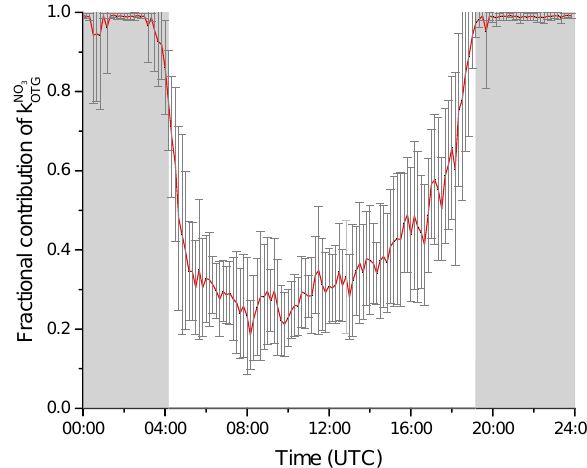
Figure 8. (a) Stationary-state NO3 mixing ratios calculated using k NO 3 comparison with the measured NO 3 mixing ratios (3 August). Panel (b) plots the time series of production and loss rates used for the calculation of [NO 3 ] ss .